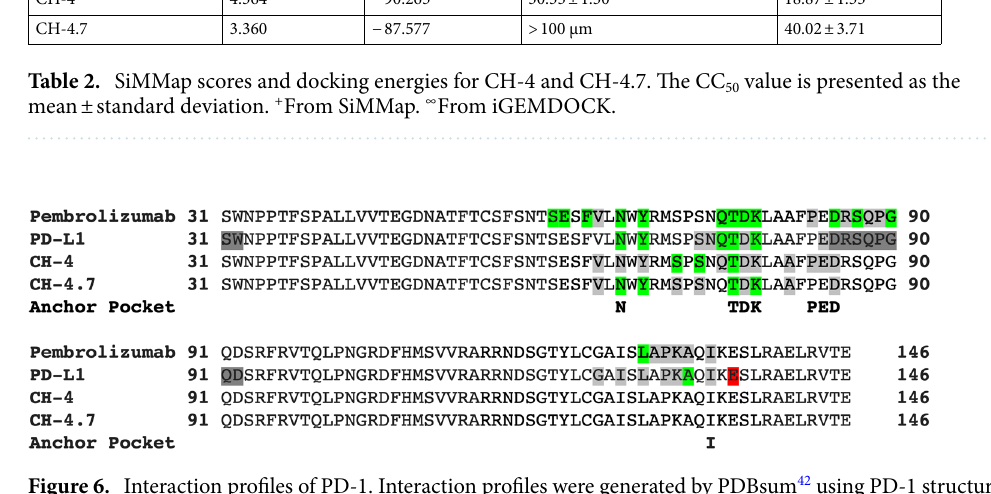
The interaction profiles of PD-1 and other molecules, including pembrolizumab Fv, PD-L1, CH-4 and CH-4.7, are illustrated in Fig. 6. We used the protein–protein interaction analysis tool from PDBsum 42 to examine the interaction residues, using human PD-1 structures complexed with pembrolizumab Fv (PDB ID: 5B8C) and PD-L1 (PDB ID: 4ZQK) 43 . Eight unmodeled residues (31S, 32 W, 85D, 86R, 87S, 88Q, 89P, and 90G) exist in the 4ZQK structure of the PD-1 domain. However, six unmodeled residues (from 85D to 90G) form part of the essential fragment in the interface between PD-1 and PD-L1, which is why we did not select 4ZQK as a target protein structure for virtual screening. The 2D interaction diagrams of CH-4 and CH-4.7 within their pocket environment were examined using the LIGPLOT program 41 and are shown in Fig. 5C,D. In Fig. 6, the interactive resides in PD-1 are highlighted as red for the salt-bridge interaction, green for the H-bonding interaction, and light gray for the non-bonding interaction. The interactions of these four molecules involve the PD-1 consensus binding residues of N66, Y68, T76, D77 and K78, which are all located in the V2, V3 and V4 anchoring domain. These three anchors may therefore play an essential role in the interference of PD-1 binding with PD-L1. The US Food and Drug Administration has approved the use of monoclonal antibodies for blocking the PD-L1/PD-1 interaction in various types of cancers 44 . However, while antibody-based immune checkpoint thera- pies have shown remarkable clinical activity, they are also associated with significant disadvantages, including the fact that the majority of patients fail to respond to treatment, intravenous injections are required, and seri- ous immune-related adverse events have occurred with the loss of immunological self-tolerance 45 . Fortunately, the advent of SMIs offers a potential alternative to monoclonal antibodies, with important clinical advantages that include more efficient uptake by the cell membrane, more specific targeting of diseased organs, prolonged therapeutic effects, lower acquisition costs, and their oral administration, which may be preferred by patients over intravenous or subcutaneous injections of monoclonal antibodies 6 . In this study, cell-based PD-L1/PD-1 interaction screening identified a potential PD-1 SMI (CH-4.7). Its inhibitory capacity was tested by blocking the membranes of Jurkat and KG-1 cells and also the soluble form of PD-L1 that interacts with PD-1 (Figs. 2 and 3). CH-4.7 effectively inhibited the PD-L1/PD-1 interaction and stimulated the production of IL-2 and IFN-γ, without influencing immune cell activity or cytokine secretion (Fig. 4). Cytotoxicity testing demonstrated minimal effects on THP-1 and Jurkat T cell lines. In the cell-based screening assay, CH-4.7 displayed a higher inhibitory capacity than PD-1 antibody treatment (Fig. 3C). Few evaluations exist of SMIs that target PD-1. Instead, the majority of SMIs that have been developed have focused on PD-L1 or related signaling molecules 46 . PD-L1 is overexpressed on the cell membrane of different types of cancers 1,35,47,48 and this overexpression enables PD-L1 to bind with PD-1 and suppress T cell-mediated antitumor immune responses, fostering tumor growth 35 . Our study focused on PD-1 SMI development and our evidence showed that CH-4.7 specifically targets PD-1 and sustains T cell activation, as according to IL-2 and IFN-γ production (Figs. 3 and 4). As shown in Fig. 3A, testing of cytotoxicity with CH-4.7 in both Jurkat and HEK293 cells revealed that HEK293 cell viability was reduced to almost 50% at the concentration of 40 μM (Fig. 3A, left panel). In Fig. 3B, CH-4.7 inhibition efficiency was reduced with the higher concentration (40 μM), due to the fact that CH-4.7 had higher cytotoxicity with HEK293. Thus, it is possible that CH-4.7 has superior inhibition efficiency under higher treatment concentrations, but the cell-based screening method used in this